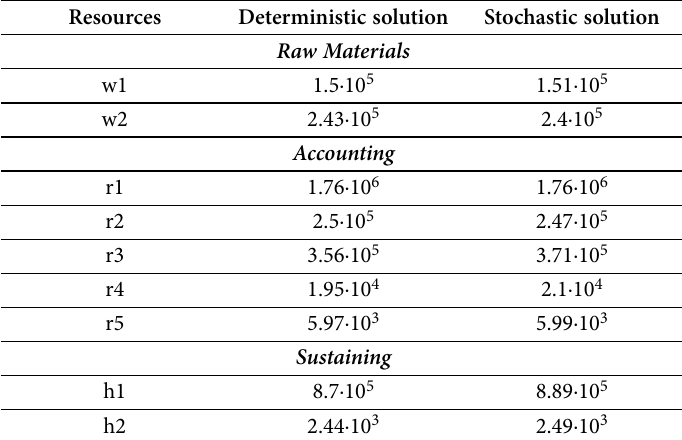
Table 7. Deterministic and stochastic solution values for the Hospital model Resources Deterministic solution Stochastic solution Raw